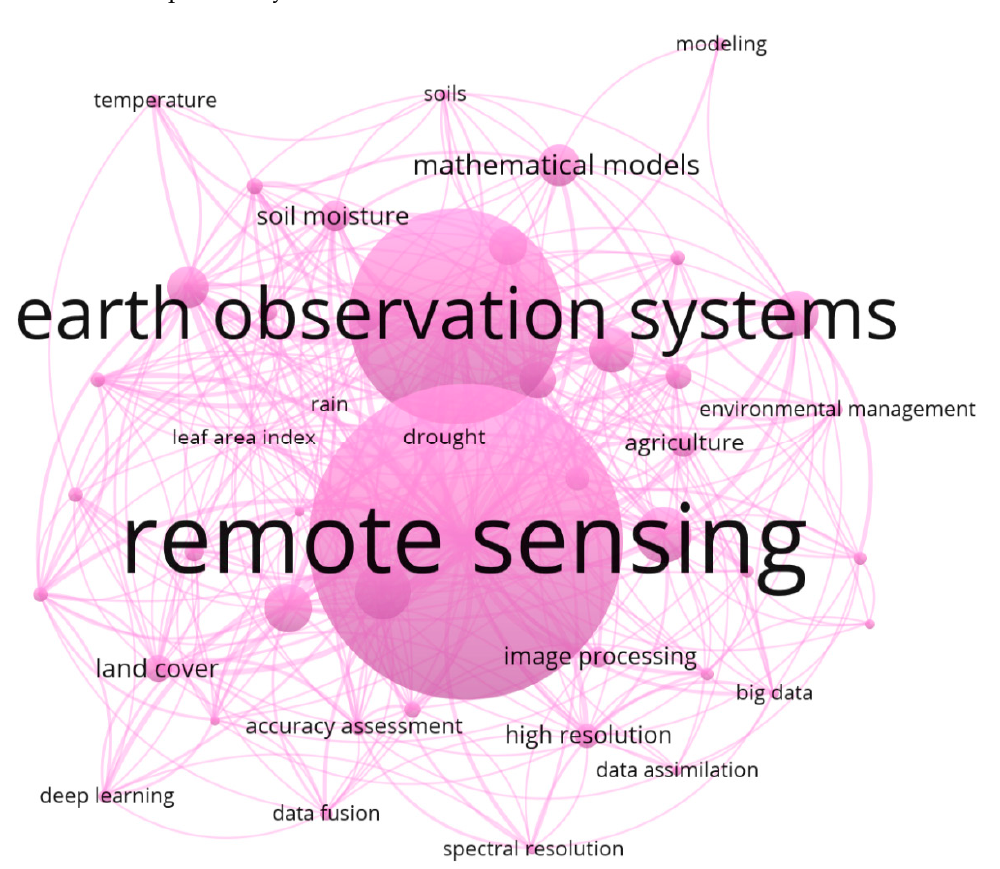
Figure 6. Top 20 keywords’ co-occurrence network on EOS and PM studies.